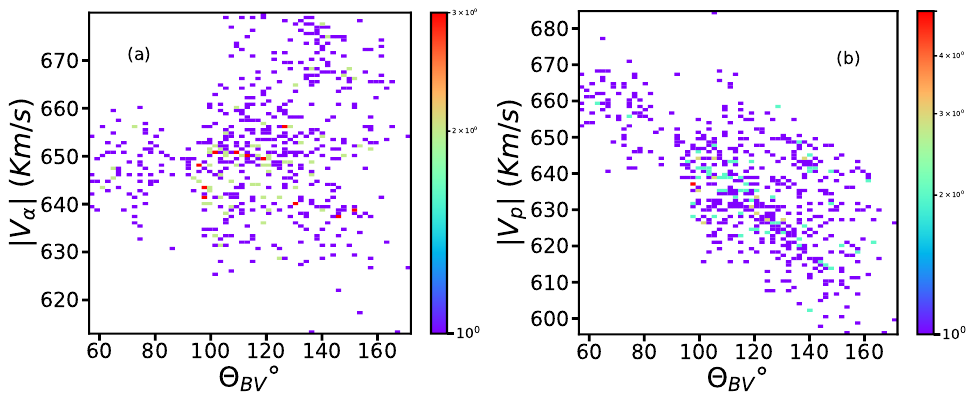
Figure 2. 2D histogram plot of ( a ) alpha bulk speed ( V α ) and ( b ) proton bulk speed ( V p ) vs. θ BV for the fast wind interval shown in Figure 1. The time of the interval is 10 June 2015. The color bar represents the number of counts.